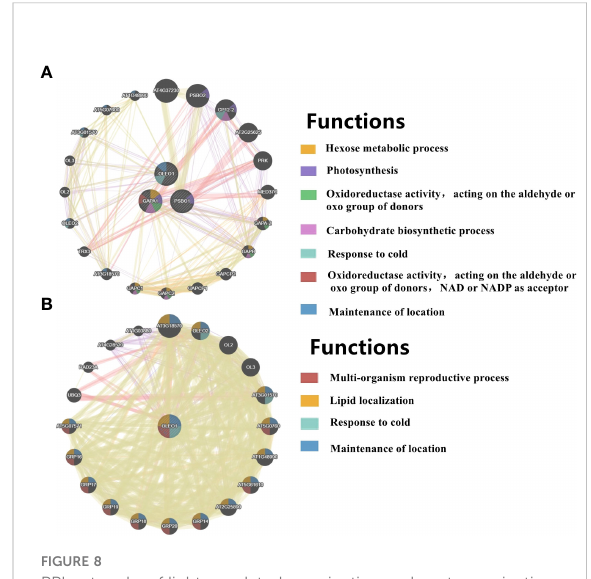
analysis, including 9 up-regulated and 5 down-regulated genes. 7 of the 9 up-regulated genes and 3 of the 5 down-regulated genes were shown consistent expression trends (Figure S12). Pearson correlation coef fi cient shows that there is correlation between transcriptome data and QRT-PCR validation results (Figure 10). These results reinforce the reliability of the sequencing data.